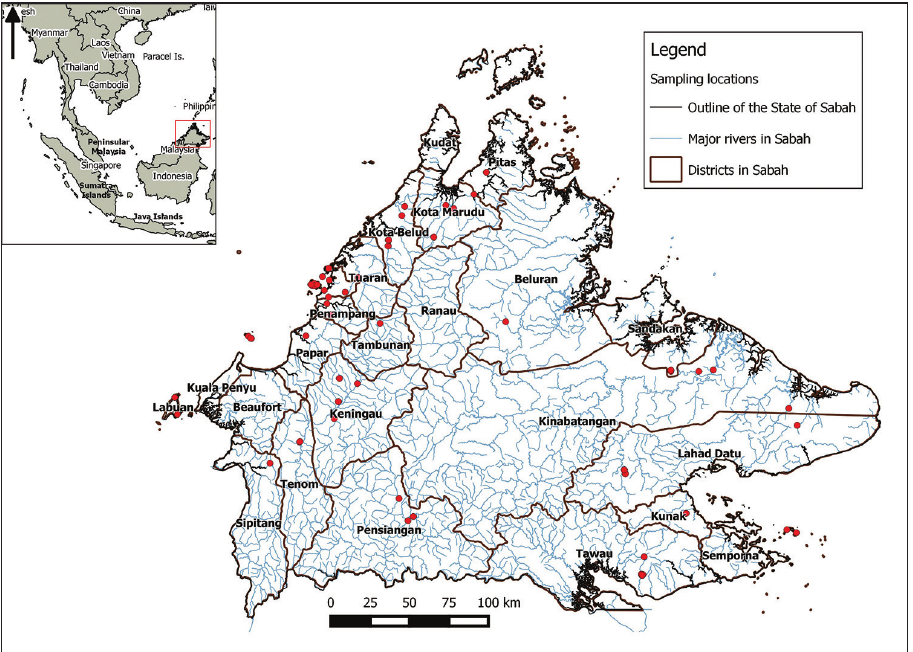
Figure 1. Map of Sabah with districts, major rivers and locations of the examined specimens (red dots). Inset shows the location of Sabah in South-east